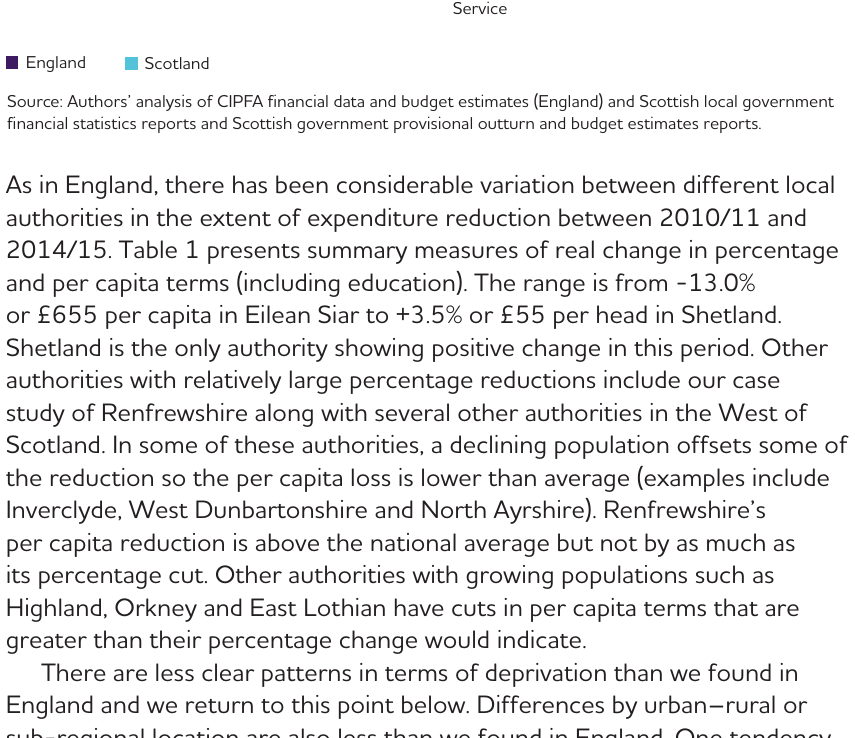
20 The cost of the cuts: the impact on local government and poorer communities